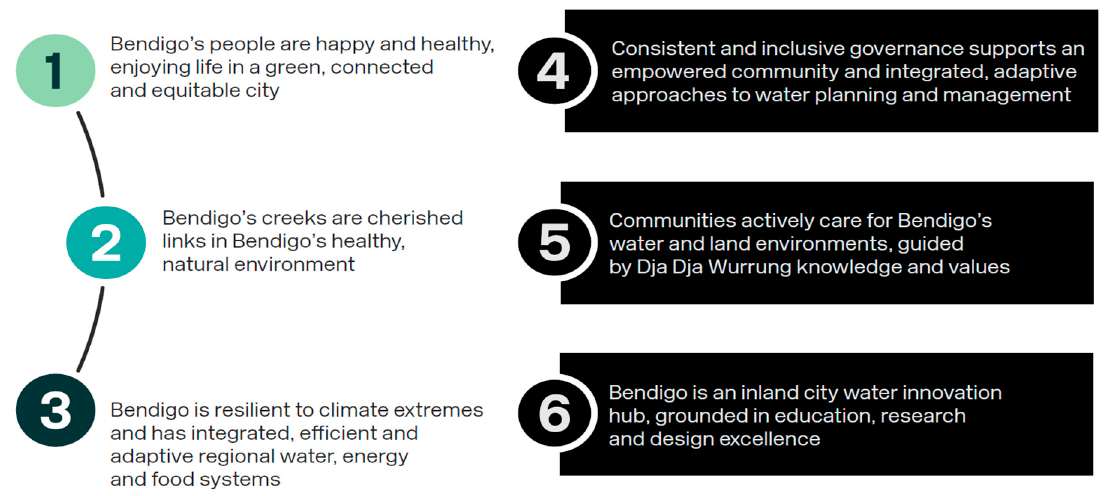
Figure 1. Community members contributed to a collaborative vision for water sensitive Bendigo [18].